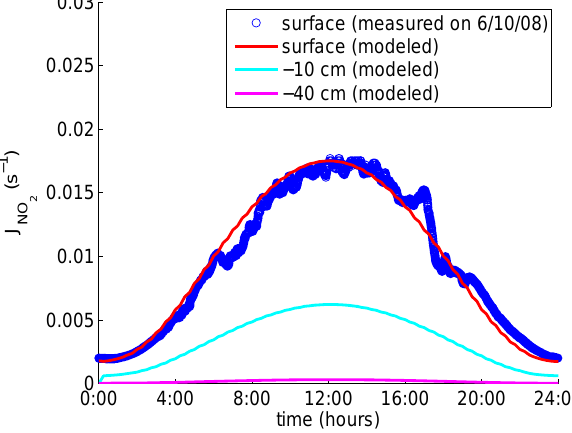
Fig. 3. J NO measured on 10 June 2008 (in blue) compared with 2 the modeled J NO (in red) at the snow surface. Modeled J NO 2 at depths of 10cm and 40cm are also